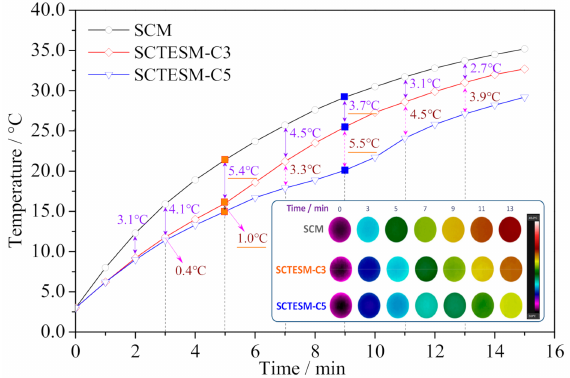
Figure 14. Upper surface temperature and infrared thermography images.